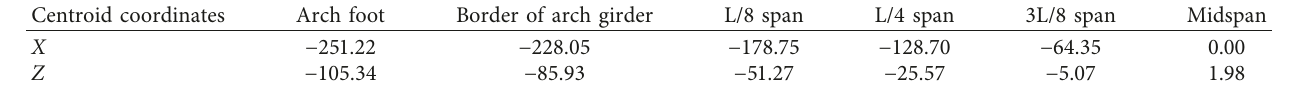
Table 2: Centroid coordinates of the six key